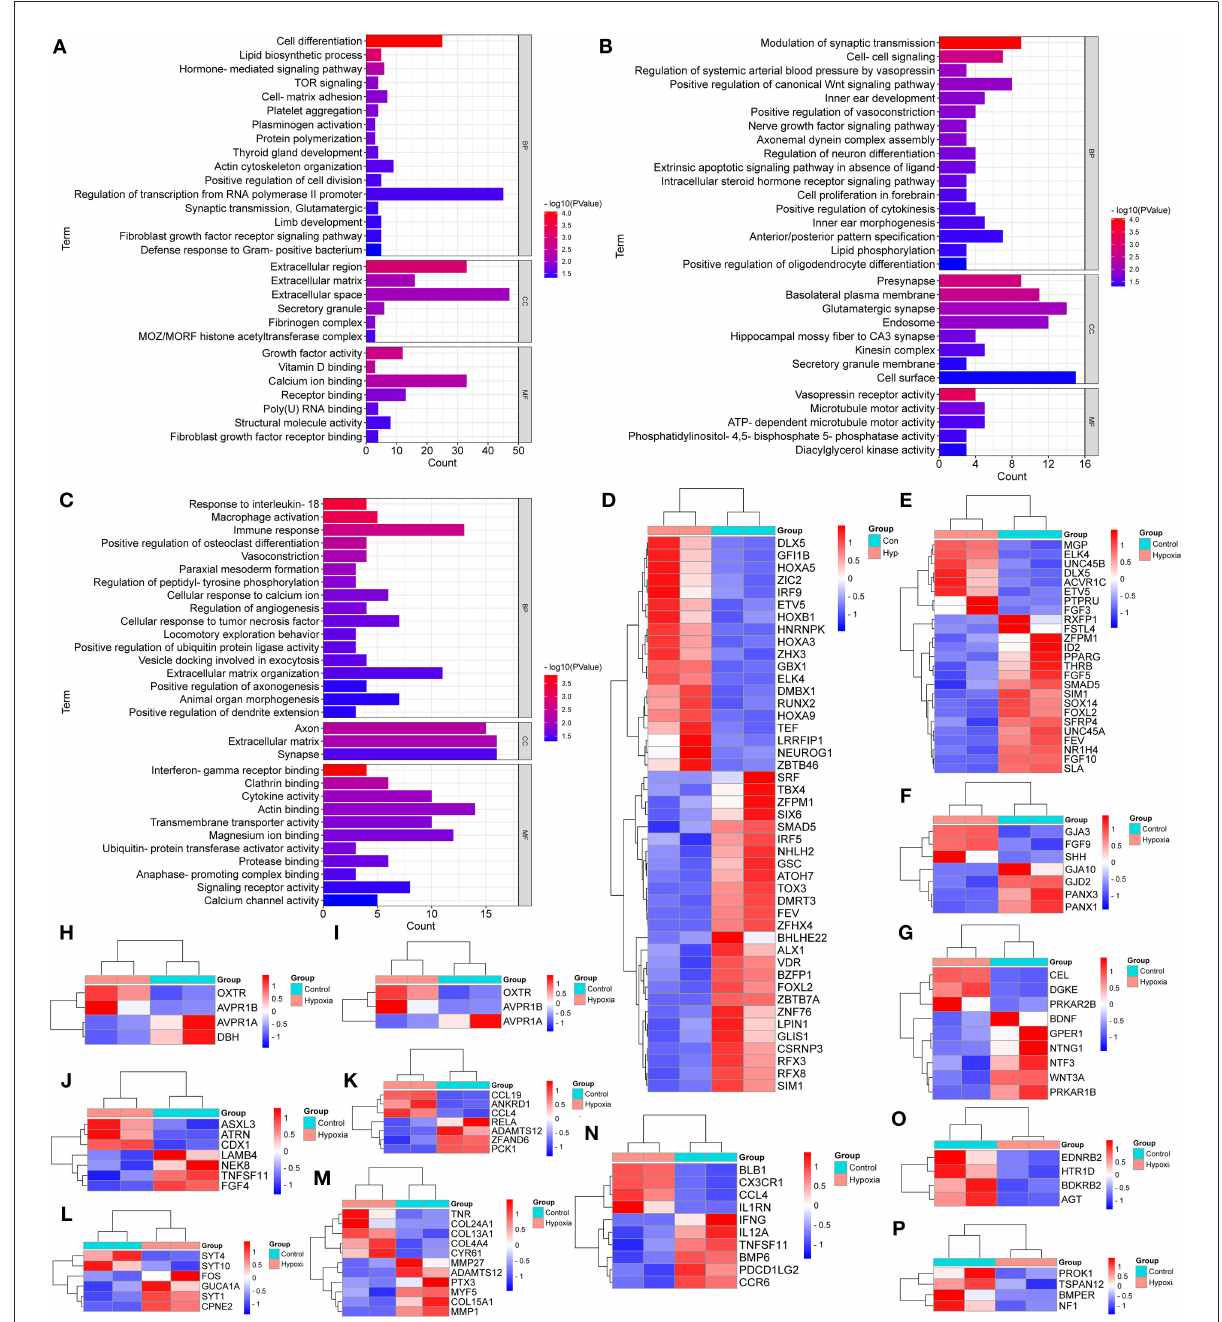
FIGURE2 GO Enrichment for the breed-special degs in the hearts of chickens treated with hypoxia and normoxia. (A–C) indicated GO enrichment for the breed-special DEGs in the hearts of SG, TB, and DRW chickens treated with hypoxia and normoxia. (D,E) indicated the heatmaps of the breed-special DEGs in cell differentiation and the regulation of transcription from RNA polymerase II promoter in SG chicken, respectively. (F–I) revealed the heatmaps of the breed-special DEGs in cell-cell signaling; the modulation of synaptic transmission; the positive regulation of vasoconstriction; and the regulation of systemic arterial BP by vasopressin biological processes in TB chicken. (J–P) showed the heatmaps of the breed-special DEGs in animal organ morphogenesis, cellular response to tumor necrosis factor, cellular response to calcium ion, extracellular matrix organization, immune response, vasoconstriction, and the regulation of angiogenesis biological processes in DRW